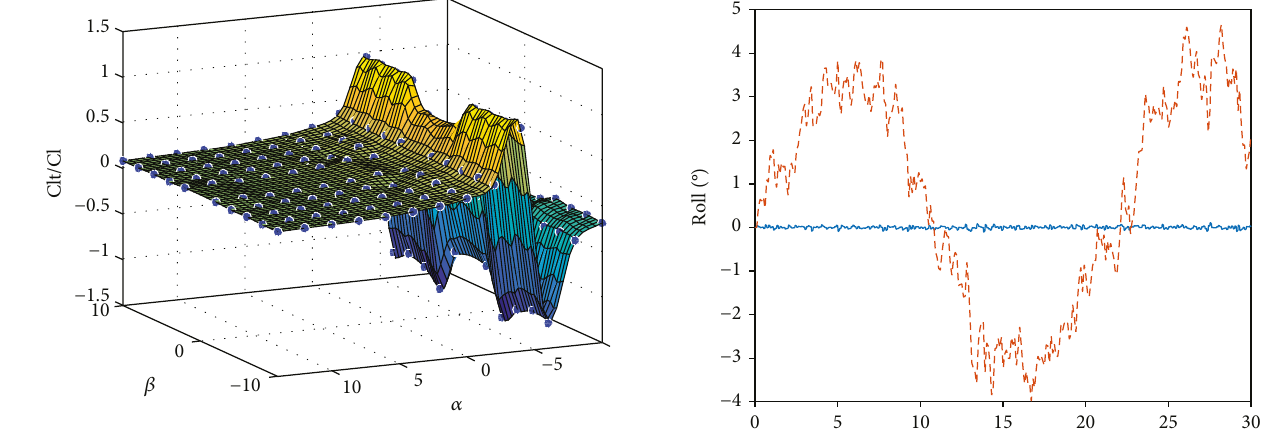
Figure 5: The ratio between the rolling moment generated by the tail (Clt) and total rolling moment (Cl).